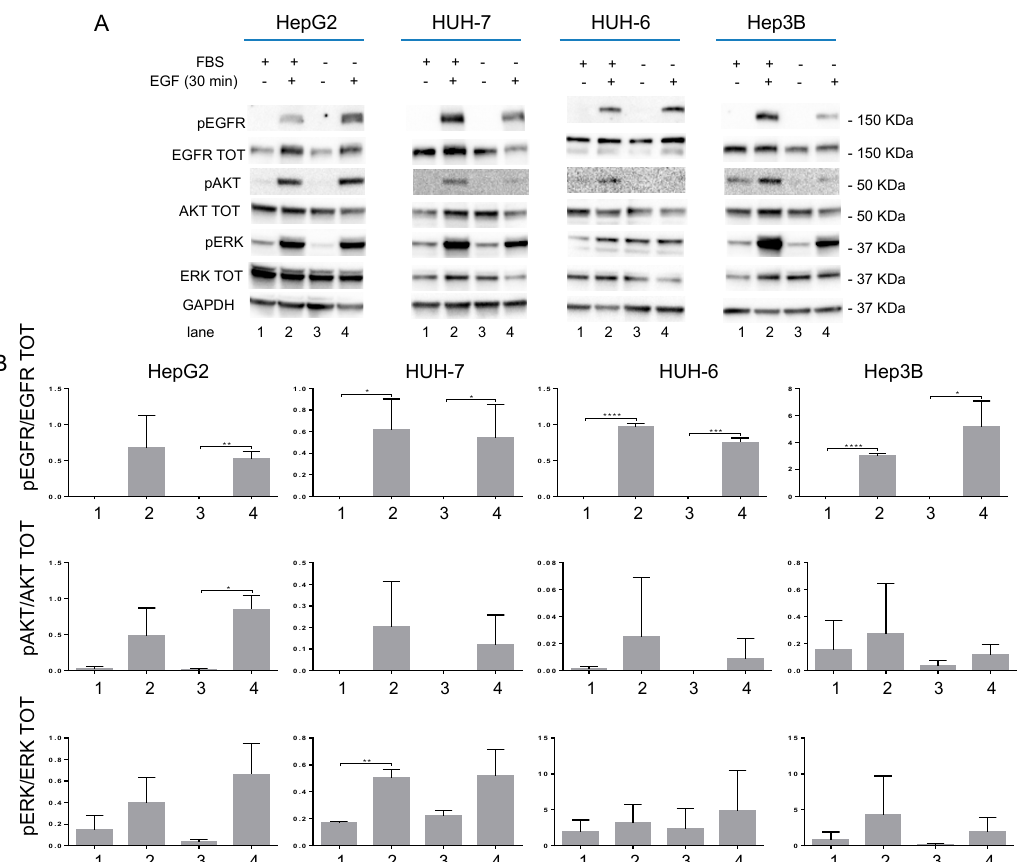
Figure 1. ( A ) Western blot analysis of EGFR pathway activation in HepG2, HUH-7, HUH-6, and Hep3B cell lines. ( B ) Densitometric analysis calculated by image lab software of the western blot shown in Figure 1A; numbers in the abscissa refer to the corresponding lane in panel A. p value < 0.05 (*); p value < 0.01 (**); p value < 0.001 (***); p value < 0.0001